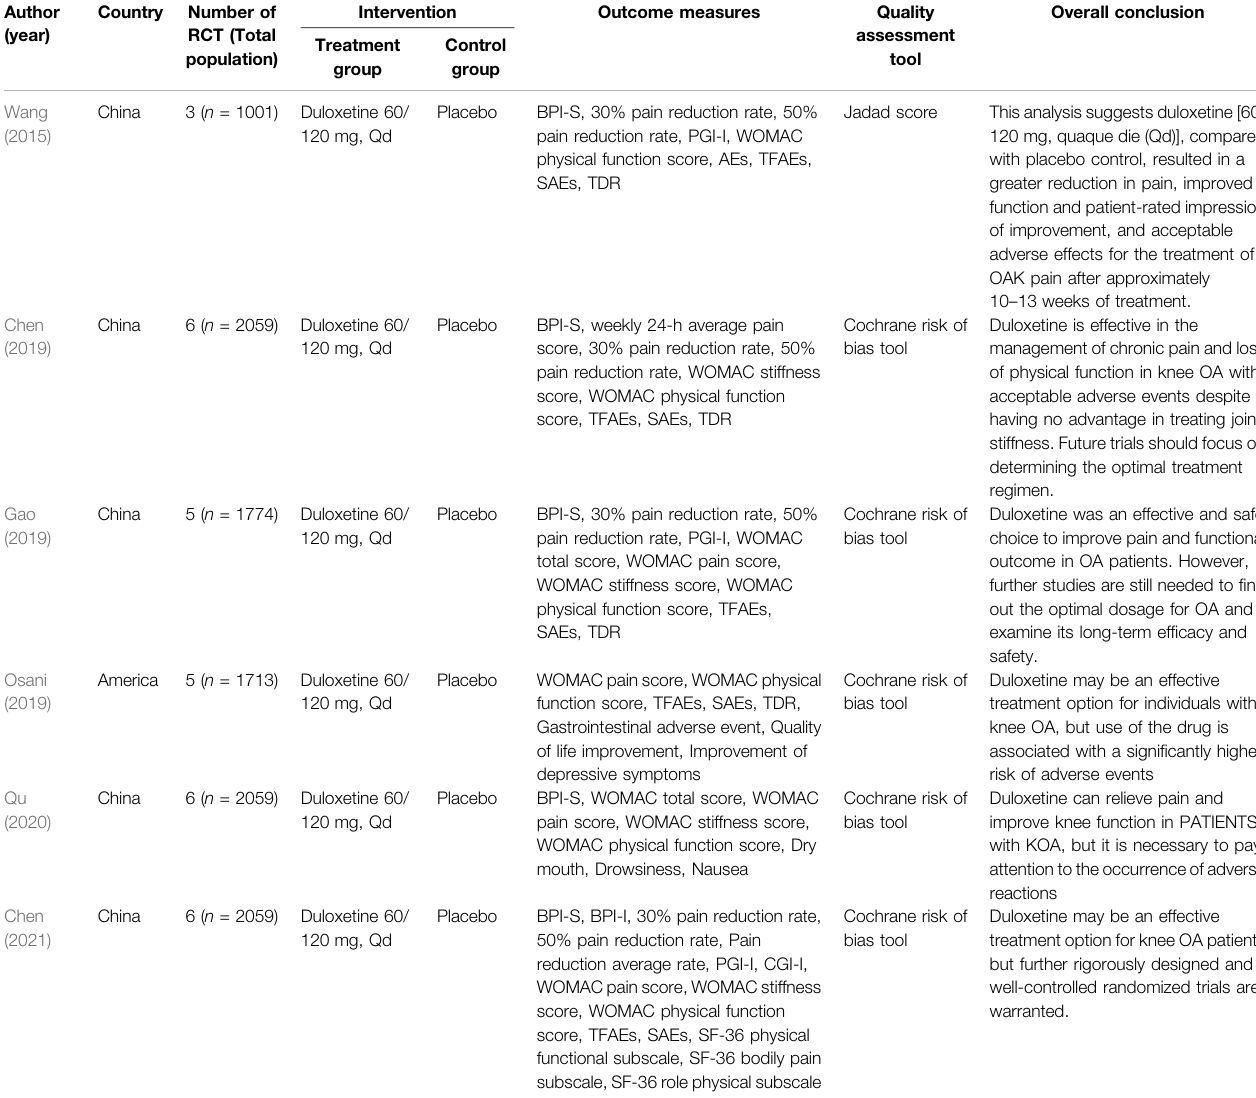
TABLE 2 | Characteristics of the included